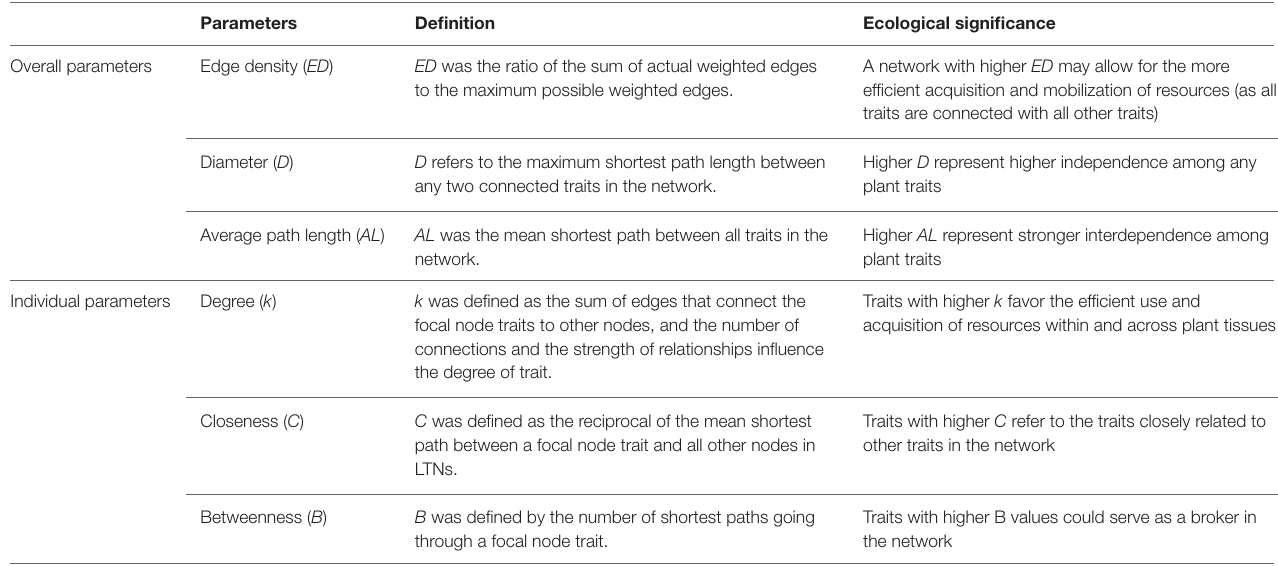
FIGURE 1 | Theoretical basi s and method used to calculate leaf trait networks (LTNs). Multiple leaf traits jointly interact with each other to adapt to the environment or to optimize leaf functions. Integrative LTNs could help capture highly complex relationships among different traits and explore the underlying strategies of plants (A,B) . Considering that plants can adjust their relationships through strength and distance, actual LTNs are shown in panel (C) . LTNs can be represented as a set of nodes (circles) connected by edges (lines) (D) . TABLE 1 | Key parameters of leaf trait networks